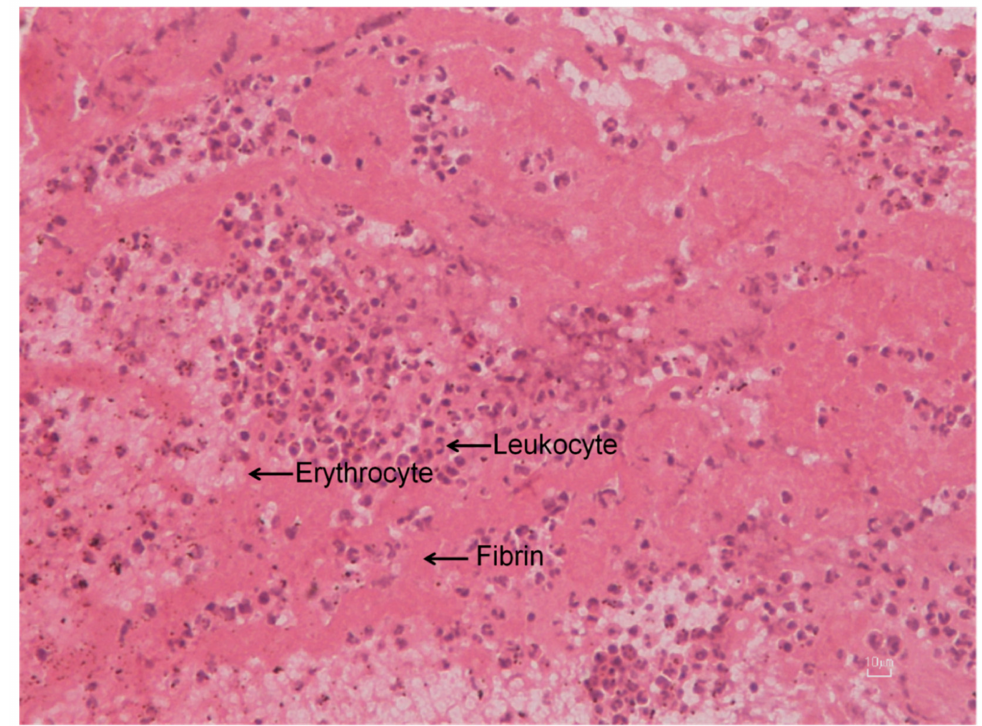
Figure 11. OM image ( × 200 magnification) of a histological examination of a thrombotic specimen revealed a thrombus characterised by fibrin/erythrocytes (occupied 70% of the total area of the thrombus) and leukocytes